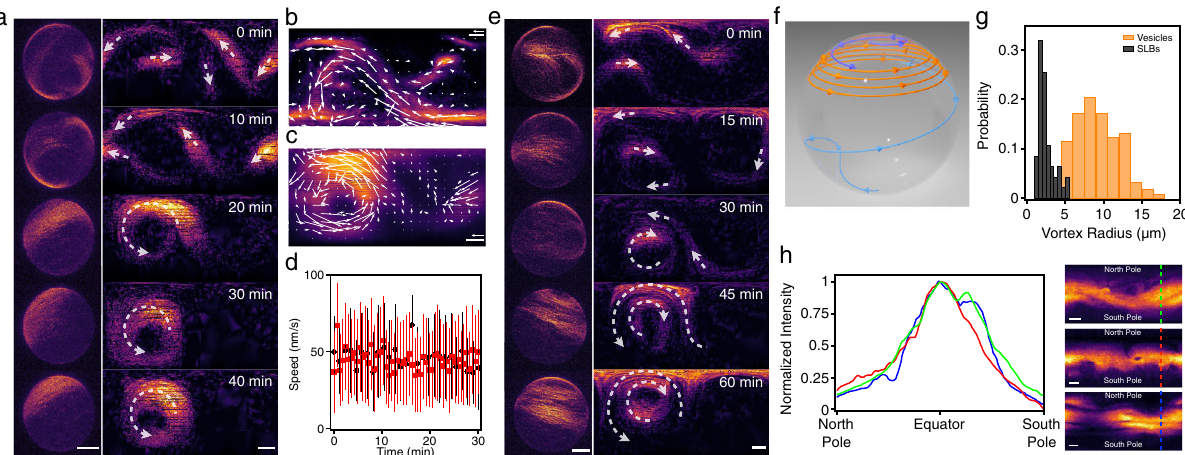
Fig. 4 Vortex formation on active actin vesicles. a , Time series of the Z-projections (left) and equirectangular projections (right) show the formation of a vortex. Arrows (white) indicate the direction of streams/vortices. Scale bars, 10 μ m. b – c Mean intensity projection overtime of the equirectangular projections of a stream at c A = 100 nM ( b ) and a vortex at c A = 300 nM ( c ). Arrows (white) show the averaged optical fl ow over time. Scale bar, 10 μ m. Arrow, 50 nm/s. d Averaged instantaneous speed after the formation of stream (circle; black) and vortex (square; red). Error bars represent the standard deviations of the velocity extracted from optical fl ow. The speed of vortices and streams are found to be consistent with each other at an average speed of ≈ 45 nm/s (stream: 46 ± 7 nm/s; vortex: 45 ± 6 nm/s). e Time series of the Z-projections (left) and equirectangular projections (right) show the formation of double vortices. Arrows (white) indicate the direction of streams/vortices. Scale bars, 10 μ m. f Schematic of the trajectories of streams during the vortex formation on a vesicle. In this case, the stream from the top hemisphere (blue) merges with the stream from the bottom hemisphere (light-blue) building up the circulating vortex (orange) at the top hemisphere. g Distributions of the radius of the vortices on vesicles (orange, bin width = 1.5 μ m) and on supported lipid bilayers 17 (black, bin width = 0.5 μ m). h The normalized intensity pro fi les of polar bands on a sphere (left). The intensity pro fi les are obtained from the equirectangular projections (right). Scale bars, 10 μ